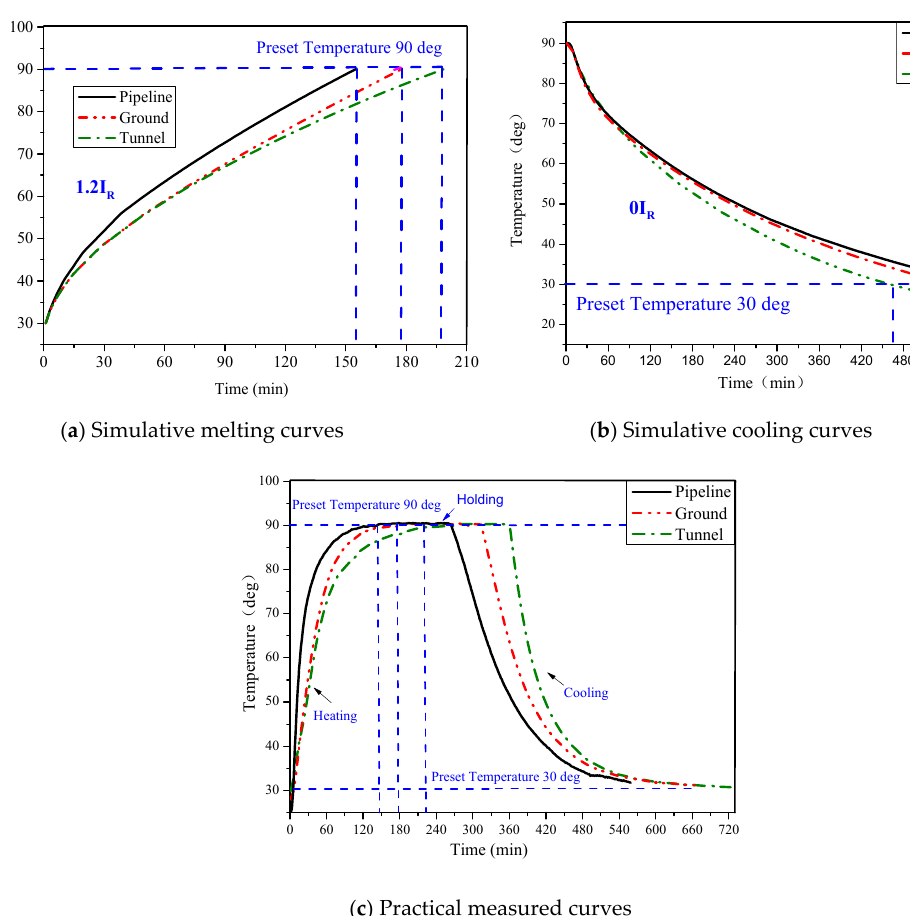
Figure 4. Simulative melting and cooling curves and practical measured curves of three different laying modes.